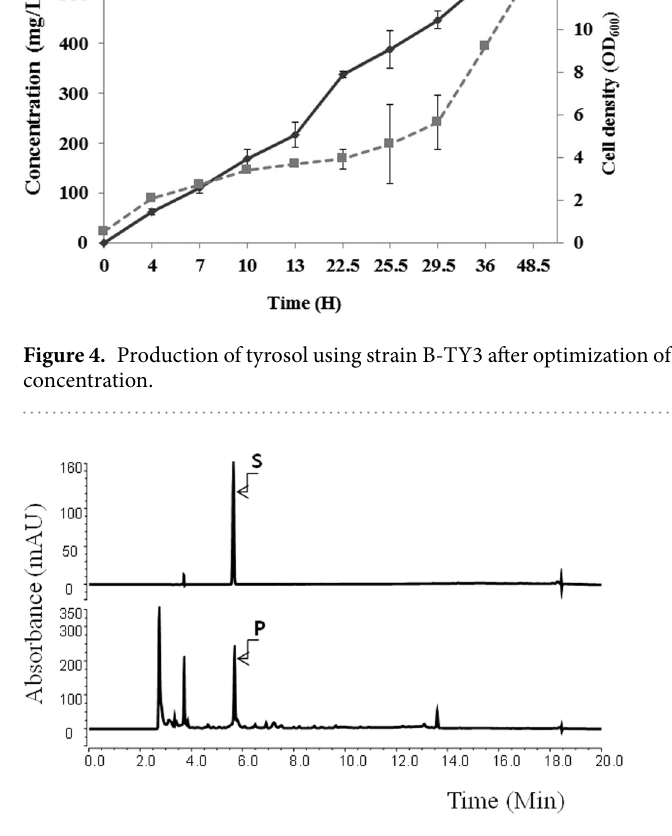
Figure 5. Production of salidroside using strain B-SAL1. S, standard salidroside; P, reaction